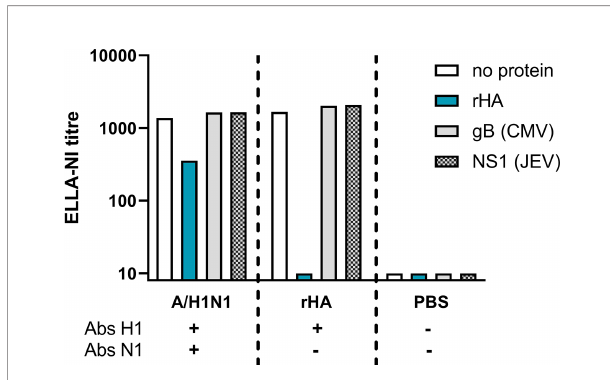
FIGURE 1 | Competitive binding of anti-HA antibodies prior to ELLA-NI testing. Sera from mice vaccinated with A/H1N1pdm09 (A/California/07/2009) monovalent vaccine, rHA (from the same strain) or PBS were pre-incubated either with no protein, with rHA (A/California/07/2009) or one of two irrelevant viral proteins (gB from CMV or NS1 from JEV). Pre-incubated sera were then tested in ELLA-NI with a live H1N1 A/California/07/2009 virus. Sera from H1N1 vaccinated mice contained speci fi c antibodies against both H1 and N1, while sera from rHA vaccinated mice were antibody positive for H1 only and sera from PBS vaccinated mice were antibody negative for both H1 and